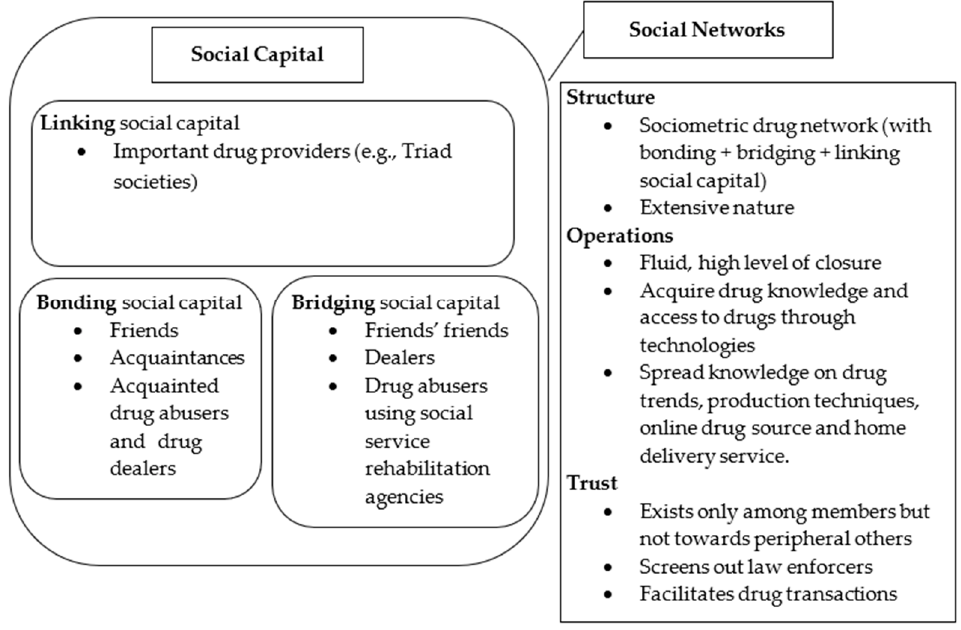
Table 1. Participants’ demographic and drug use data.